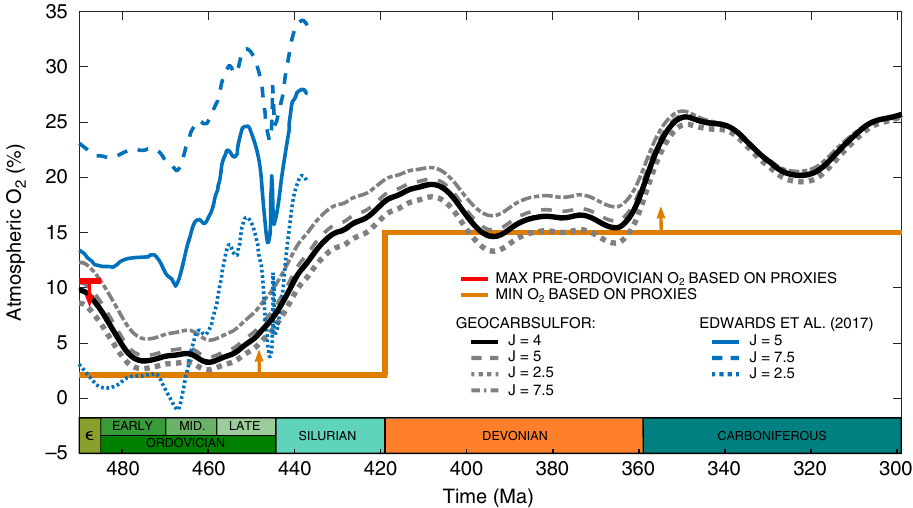
Fig. 6 The effect of the parameter, J , on GEOCARBSULFOR oxygen outputs, compared to another method of calculating atmospheric oxygen. The black line is our baseline model run with J = 4. The grey dashed line is J = 5, the grey dotted line is J = 2.5, and the grey dot-dash line is J = 7.5 for our GEOCARBSULFOR model. The blue line is J = 5, the dashed line is J = 7.5 and the dotted line is J = 2.5 from Edwards et al. 55 . The red line shows the approximate maximum atmospheric O 2 (10.4% atm) for the Cambrian and earlier, based on geochemical water column redox data and allowing for modelling uncertainties 14,72,73 . The orange line is the approximate O 2 minimum, based on the same redox data, as well as Cambrian biota and wild fi